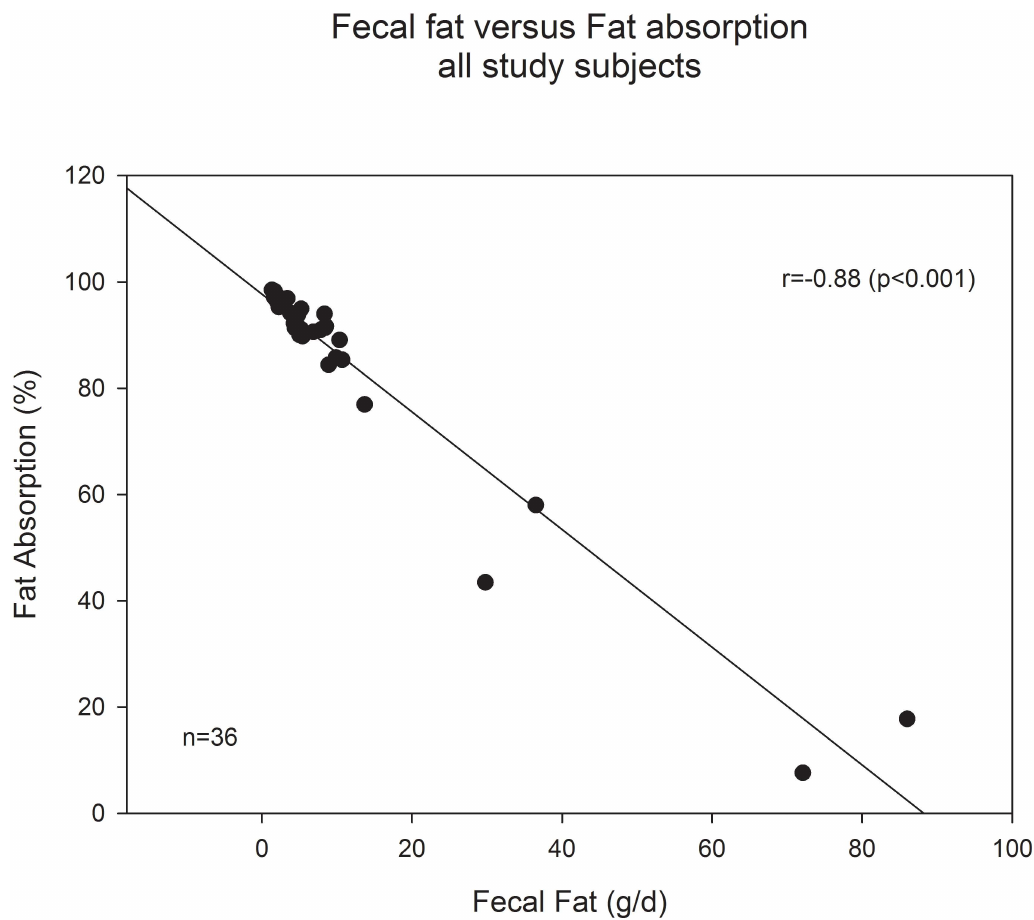
Fig 2. Correlation of fecal fat (g/d) vs fat absorption (%) in relation to fat intake (g/d). All study subjects.